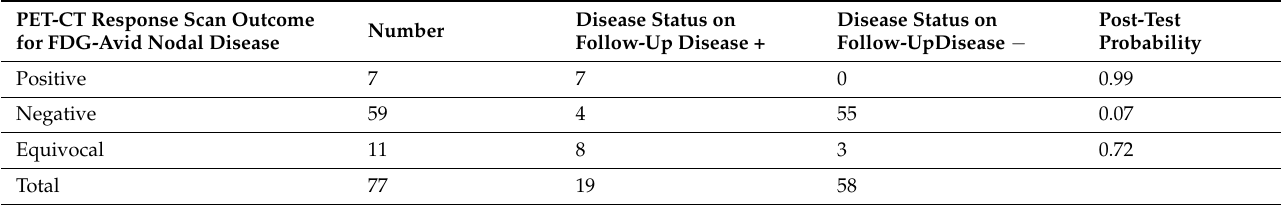
Table 4. Lymph node response ( n =